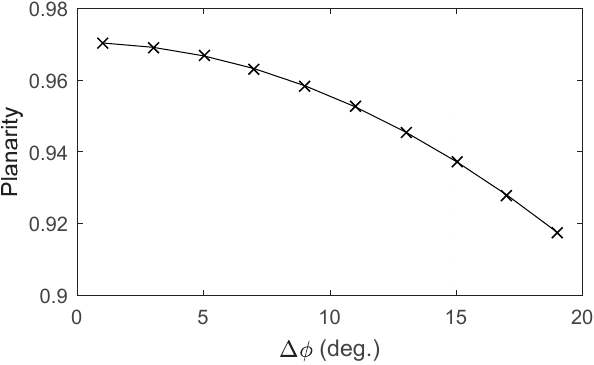
φΔ in the same condition of Figure 6. Figure 10. Planarity with respect to the ∆ φ in the same condition of Figure